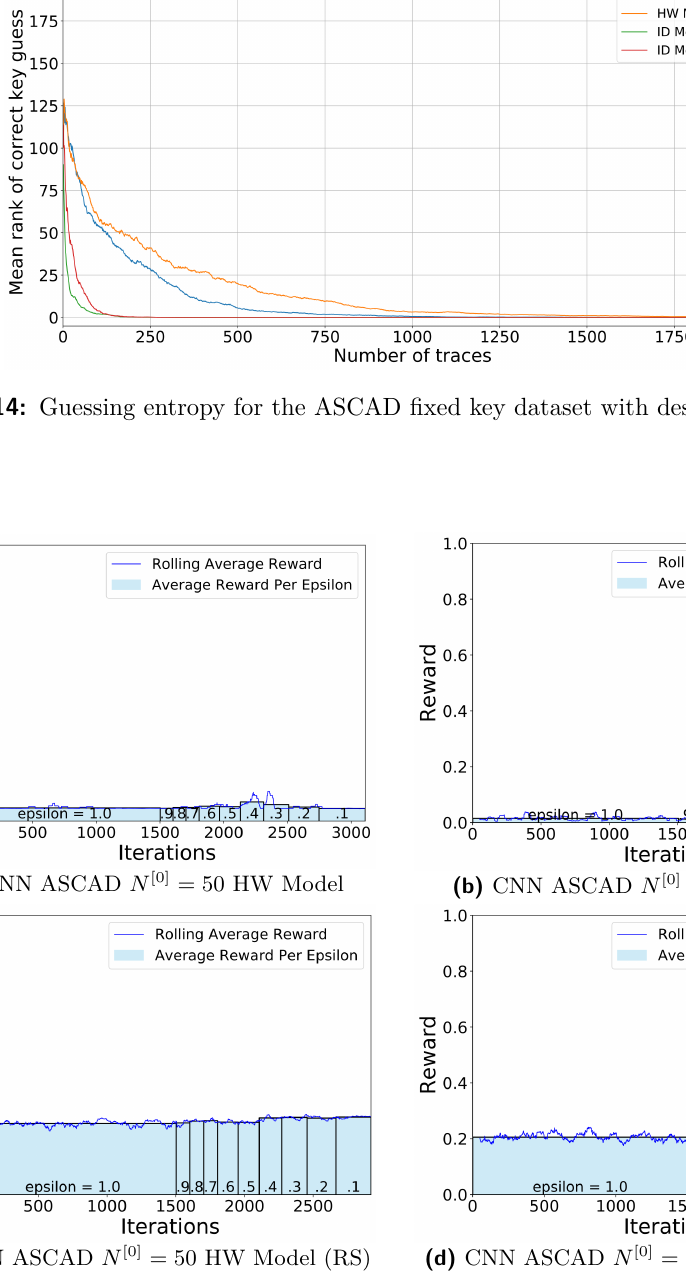
Figure 15: An overview of the Q-Learning performance for the ASCAD fixed key dataset with desynchronization of 50 experiments. The blue line indicates the rolling average of the Q-Learning reward for 50 iterations, where at each iteration, we generate and evaluate a neural network architecture. The bars in the graph indicate the average Q-Learning reward for all neural network architectures generated during that ε